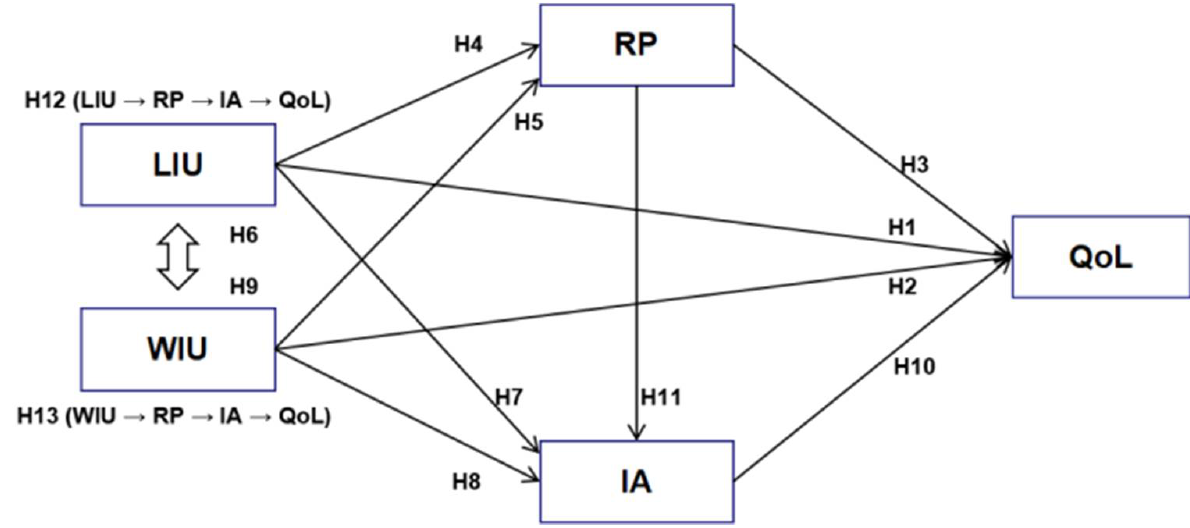
Figure 1. Theoretical framework.